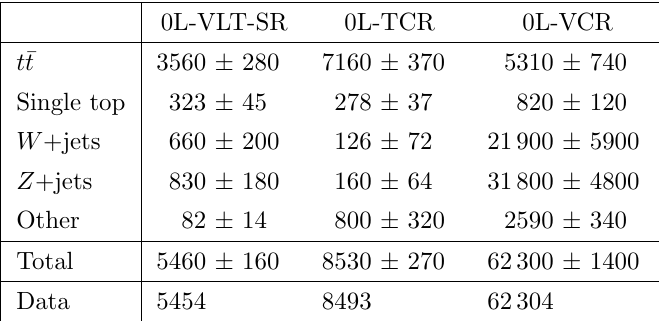
Table 7 . Numbers of events observed in the signal and control regions used for the vector-like T - quark search, together with the estimated SM backgrounds in the (cid:12)t to data, under the background- only hypothesis. The uncertainties include statistical and systematic uncertainties. The uncertain- ties in the individual backgrounds are correlated, and do not necessarily add in quadrature to the total background